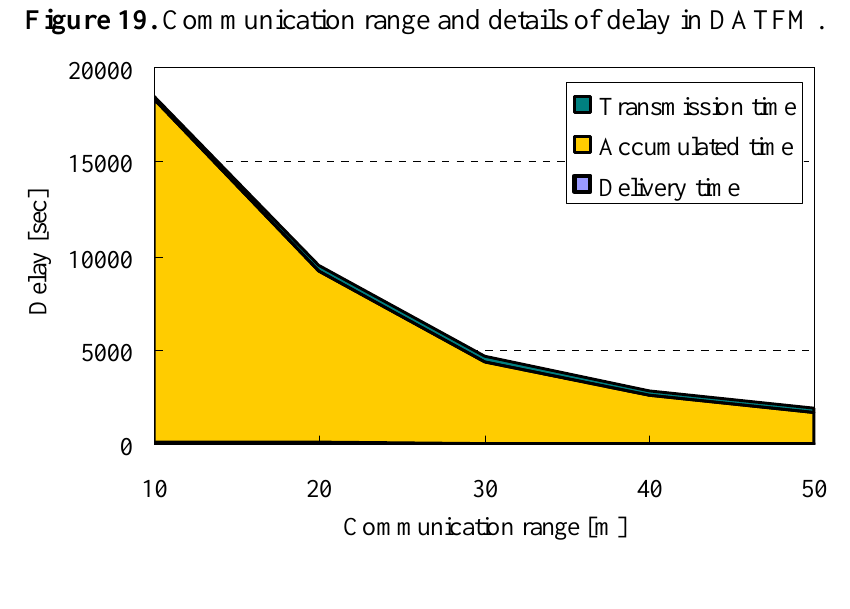
Figure 20. Communication range and control